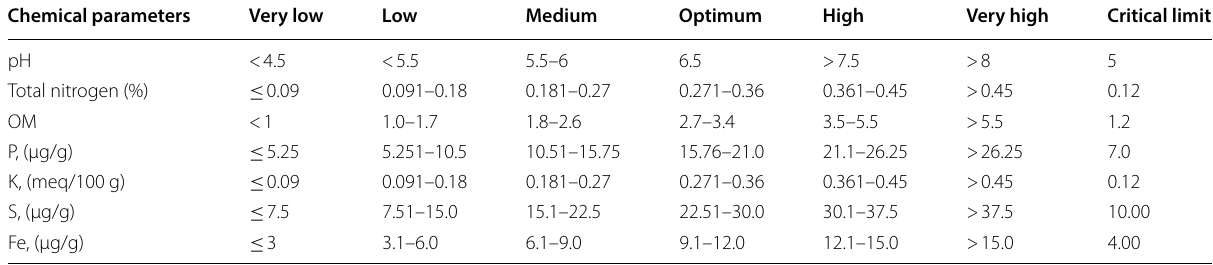
Table 1 Recommended soil chemical test values for upland crops interpretation. Source Regional Laboratory, Soil Resource Development Institute, Bangladesh (2014) Chemical parameters Very